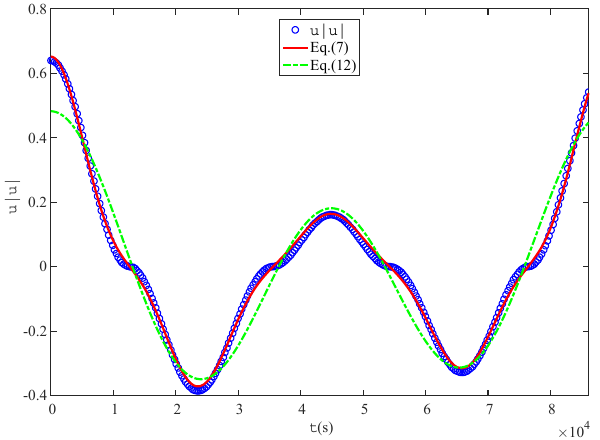
Figure 4. Computed effective friction coefficients F 1 (a) and F 2 (b) from Eqs. (13) and (14) as a function of ε 1